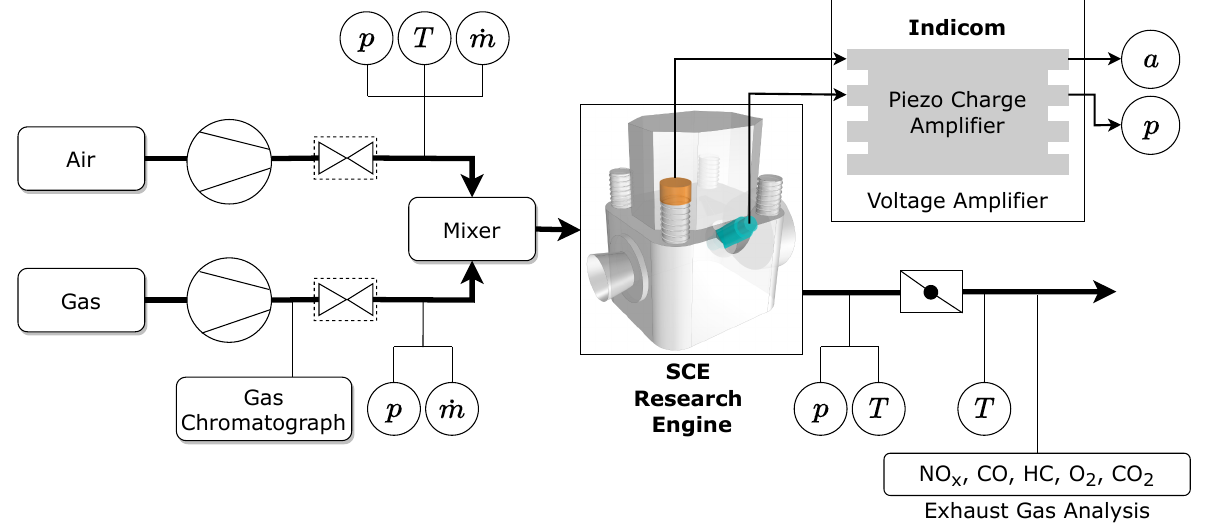
Figure 1. Schematic diagram of experimental setup with marked positions for in-cylinder PS (cyan) and KS